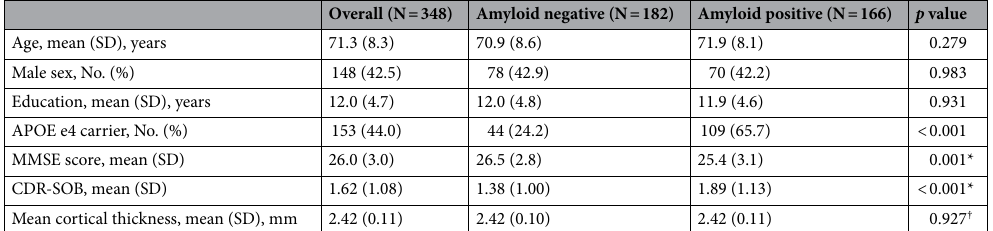
Table 1. Clinical characteristics of participants (N = 348). Data are presented as mean (standard deviation) for continuous variables and N (%) for categorical variables. MMSE mini-mental state examination, CDR- SOB Clinical Dementia Rating Scale Sum of Boxes. * p values were obtained from linear models, corrected for age, sex, and educational attainment. † p values were obtained from linear models, corrected for age, sex, and intracranial